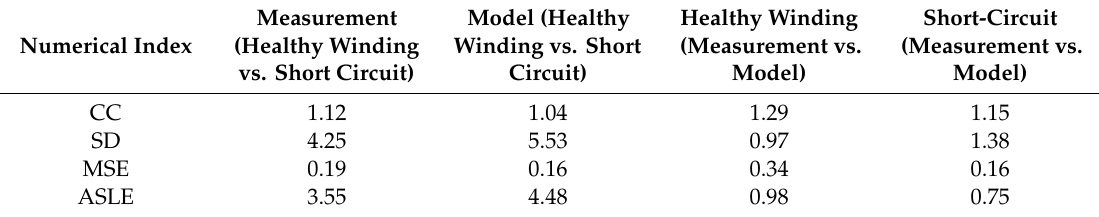
Table 1. Results of the assessment with CC, SD, MSE, and ASLE